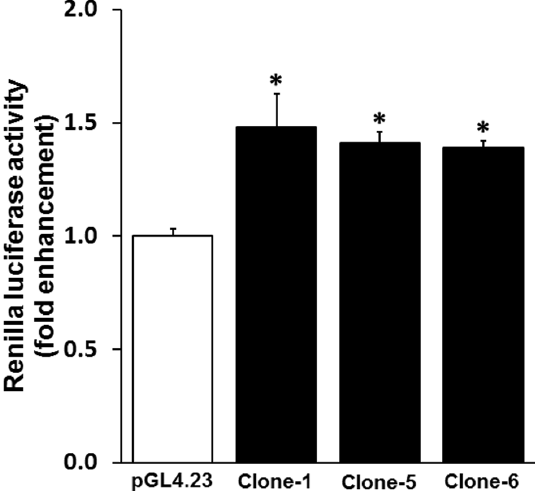
Figure 4. Functional activity of clone-1, clone-5 and clone-6 expressed in CaCo2 cells. The CaCo-2 cells were transfected with either a vector (pGL4.23), clone-1, clone-5, or clone-6. After the transfection, the luciferase activity was measured in the presence and absence of aldosterone (10 nM) treatment. Relative luciferase activity was normalized to the luciferase activity present in the vector transfected cell (pGL4.23; considered 1.0). Data presented represent mean 6 SE, from triplicate assays from 3 different experiments). * p , 0.05– compared to pGL4.23.